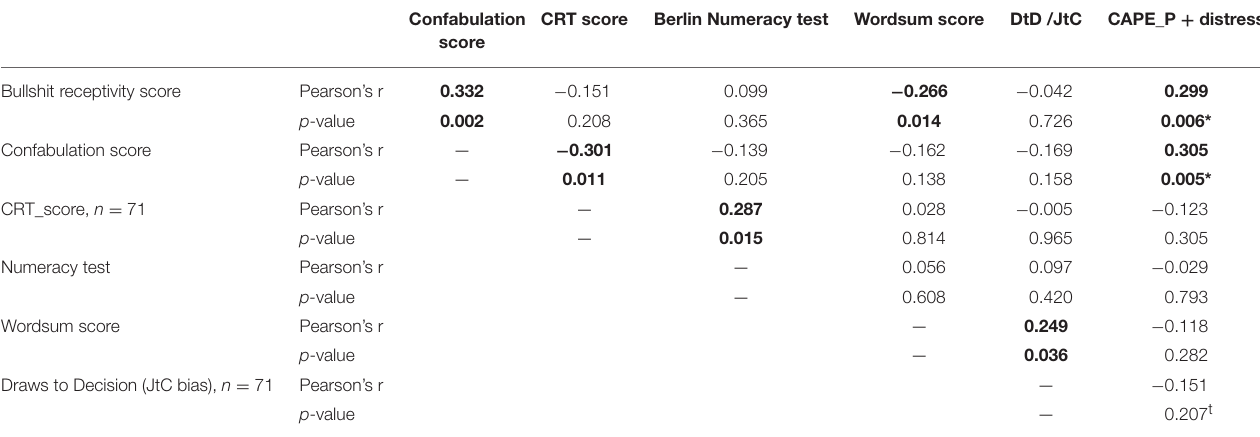
TABLE 1 | Pearson correlation among the six tasks and the CAPE-P